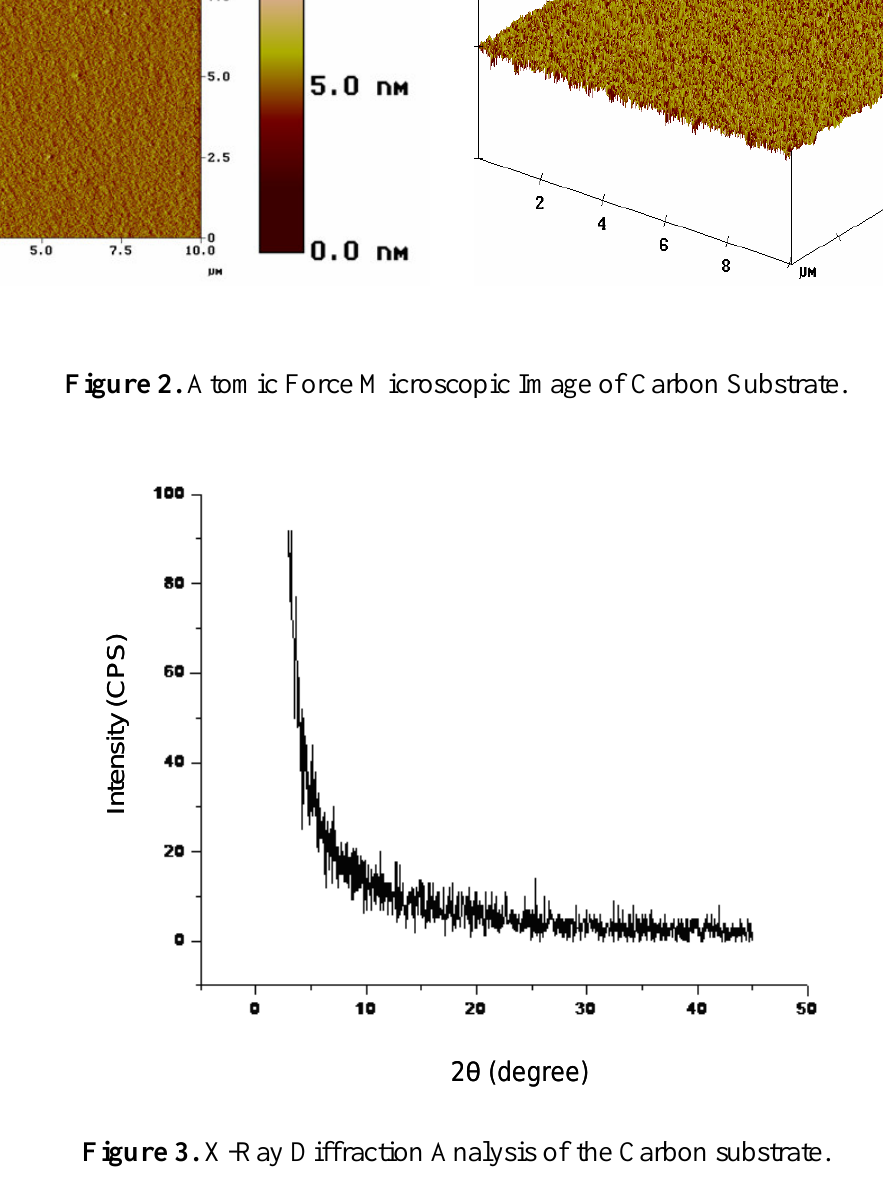
Figure 3. X-Ray Diffraction Analysis of the Carbon